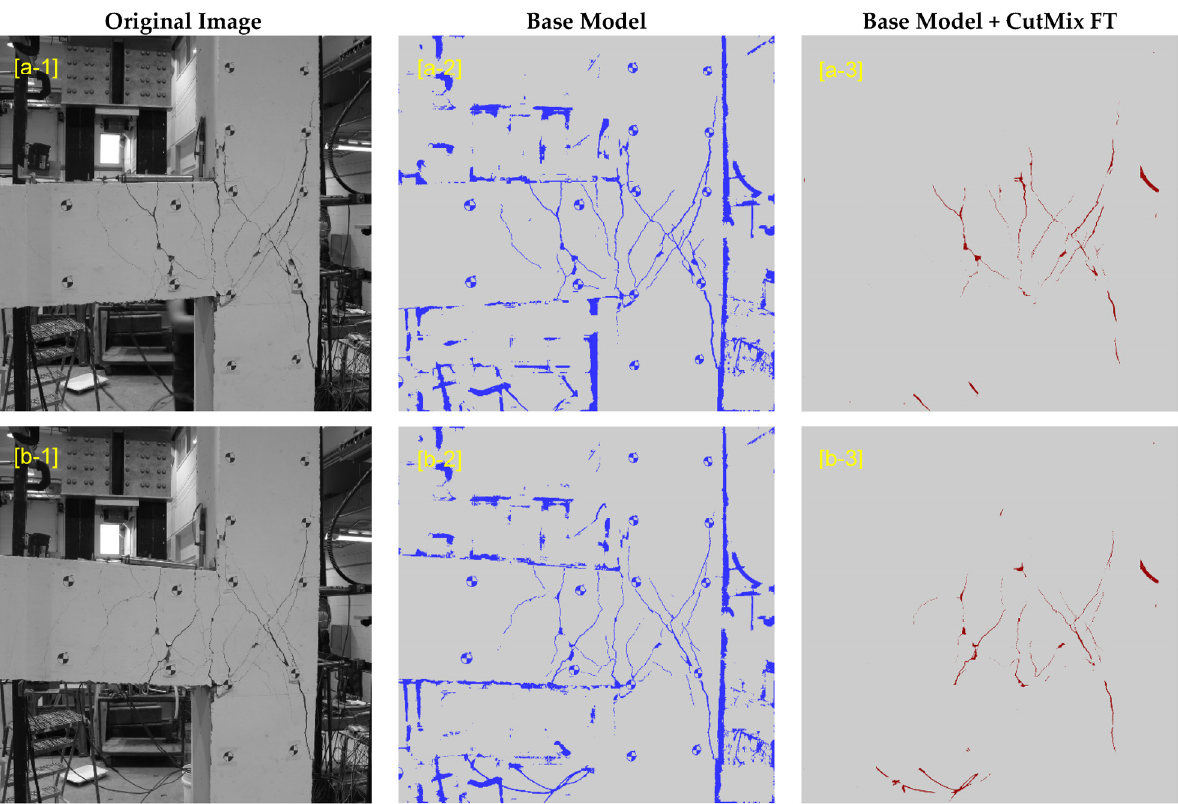
Figure 9. Samples of crack mask outcomes for the Base Model and the model fine-tuned with CutMix data synthesis for the last cycle of ([a-1]–[a-3]) downward and ([b-1]–[b-3]) upward loading (FT: fine-tuned).